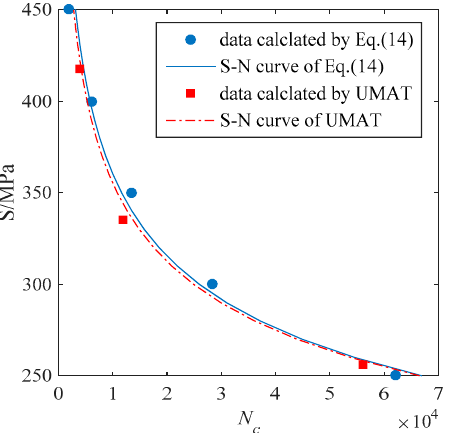
Figure 6. S-N curve of steel wire with a hemispherical pit under uniaxial tensile fatigue load.